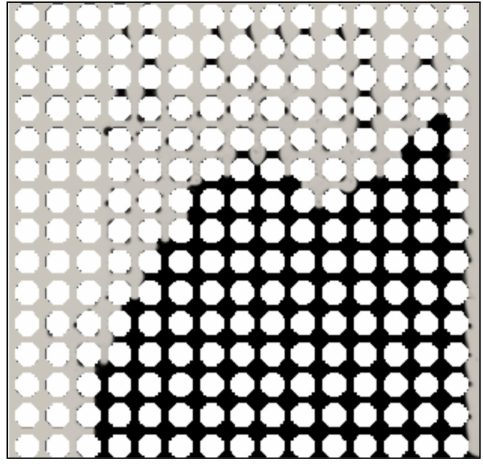
Figure 10. Oil saturation in the porous media after 4.2 h. The black and grey colors show oil and solvent phases, respectively, and the white shapes are grains.